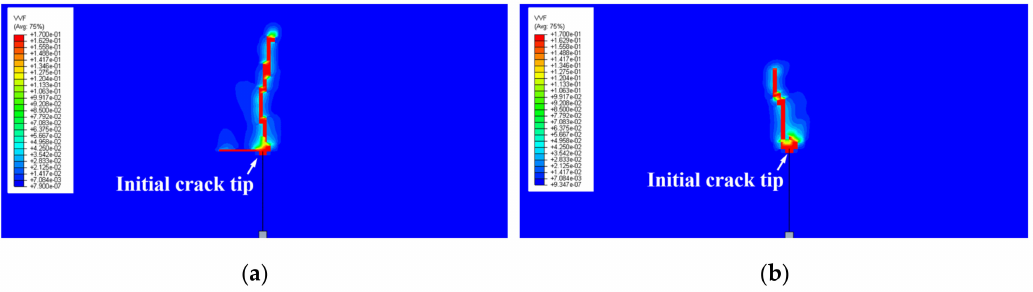
Figure 10. The typical crack propagation paths when the models with 0.6 times ( a ) and 0.8 times ( b ) the true stress versus strain curves of the ductile material A508 were assigned to the left